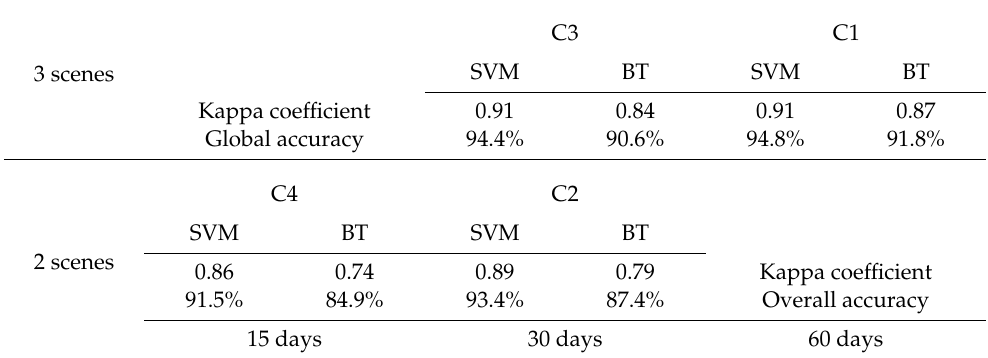
Table 9. Accuracy assessment of the algorithms used as a function of the acquisition dates of the scenes